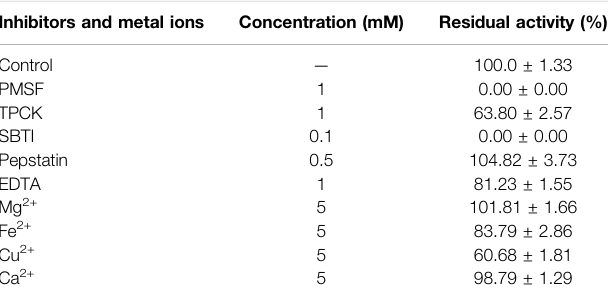
TABLE 4 | Effects of inhibitors and metal ions on fi brinolytic activity against EPF3 (mean ± SD, n (cid:1) 3). Inhibitors and metal ions